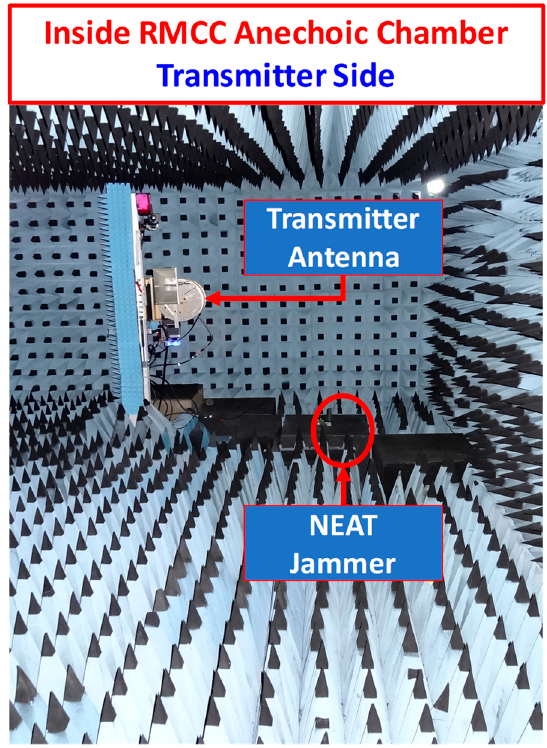
Figure 8. Transmitter Antenna Inside the Chamber Room.